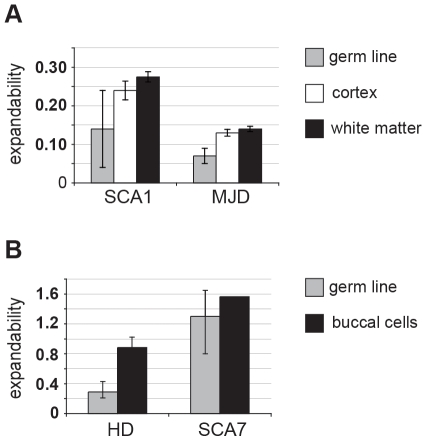
Intergenerational instability is predictive of somatic instability.(A) Repeat-length normalised levels of somatic mosaicism in the brains of SCA1 and MJD patients is similar to the levels of germ line instability observed in these disorders. Data were obtained from meta-analysis of a published study of somatic mosaicism in the cerebral cortex (NMJD = 11, NSCA1 = 7) and white matter (NMJD = 9, NSCA1 = 6) of SCA1 and MJD individuals (Table S1) (Maciel et al, 1997). (B) Repeat-length normalised levels of somatic mosaicism in buccal cells of HD and SCA7 patients is similar to the levels of germ line instability observed in these disorders. Data were obtained from meta-analysis of published studies of somatic mosaicism in the buccal cells of HD (N = 12) [8] and SCA7 (N = 1) [34] individuals (Table S2).